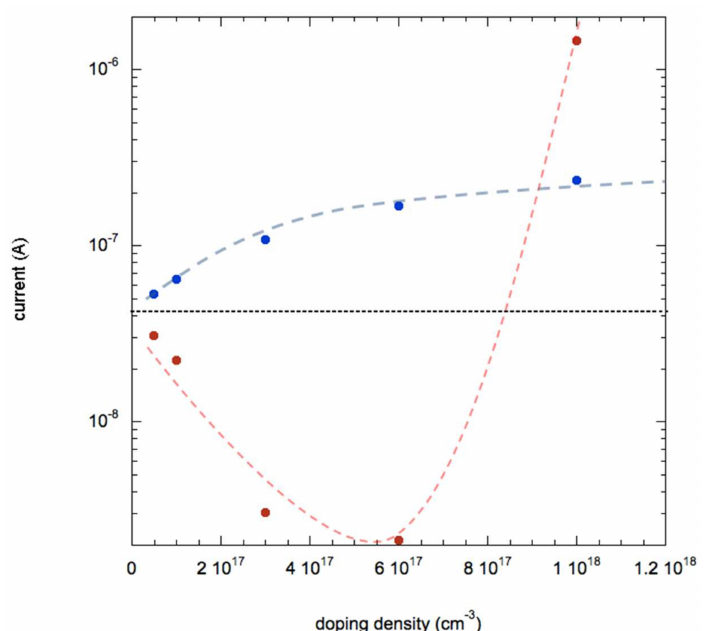
Figure 8. Current dependence on additional dopant density due to molecular charge transfer for electrons (n-doping, red symbols) and for holes (p-doping, blue symbols). The dotted black line indicates the value for a NW without charge transfer. Dashed lines are guide for the